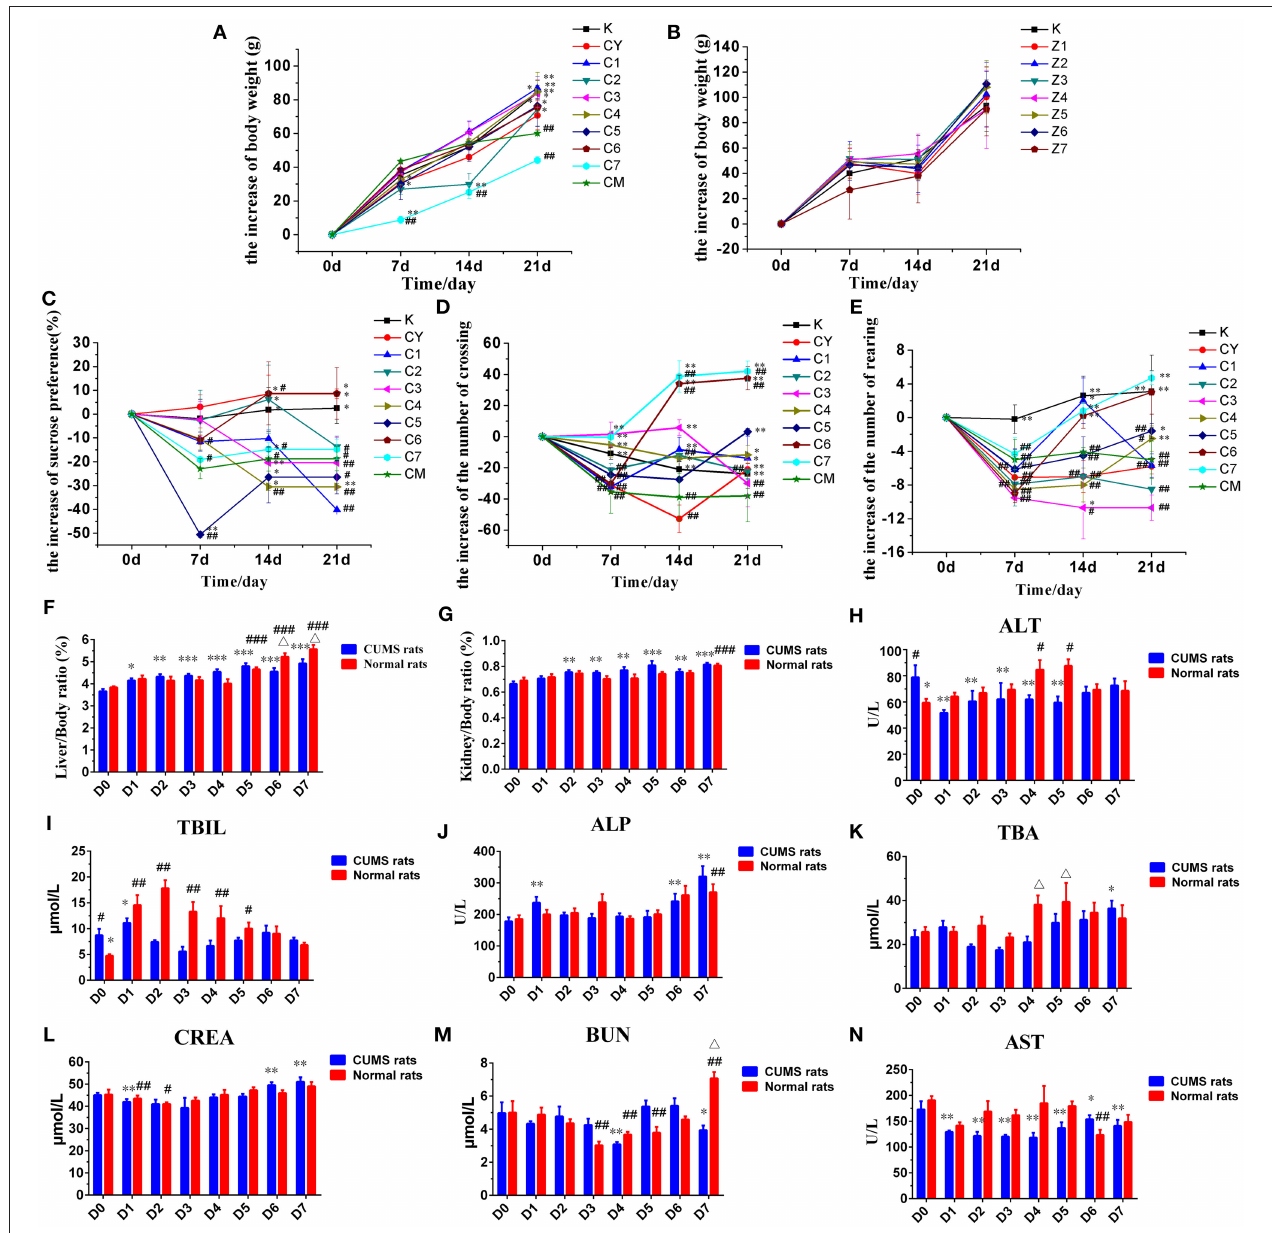
FIGURE 1 | Effects of PBR on body weight of CUMS rats (A) and healthy rats (B). Effects of PBR on the sucrose preference test (C) , the number of crossings (D) and the number of rearings (E) . Effects of PBR on biochemical parameters and visceral index: (F) Liver/Body weight ratio, (G) Kidney/Body weight ratio, (H) ALT, (I) TBIL, (J) ALP, (K) TBA, (L) CREA, (M) BUN, (N) AST. Data are presented as mean ± SEM. n = 8 each group. CUMS rats ( blue), normal rats ( red). D0: administration of equal volumes of vehicle. D1: the concentration of PBR was 0.1g/ml (expressed as the weight of raw materials). D2: the concentration of PBR was 0.3g/ml. D3: the concentration of PBR was 0.6g/ml. D4: the concentration of PBR was 1.25g/ml. D5: the concentration of PBR was 2.5g/ml. D6: the concentration of PBR was 5.0g/ml. D7: the concentration of PBR was 10.0g/ml. * P < 0.05, ** P < 0.01, *** P < 0.001 vs. [CM] group; # P < 0.05, ## P < 0.01, ### P < 0.001 vs. [K] group; 1 p < 0.05, normal rats vs. CUMS rats at the same concentration of PBR in the biochemical